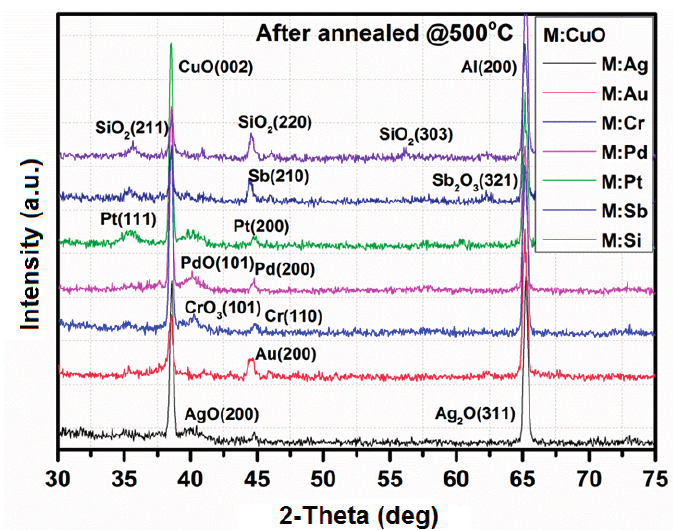
Figure 4. XRD patterns of M:CuO (M: Ag, Au, Cr, Pd, Pt, Sb, Si) doping agents after annealing at 500 °C for 4 h in air. Table 1. Crystallographic parameters of thin films after annealing at 500 °C for 4 h in air. Thin